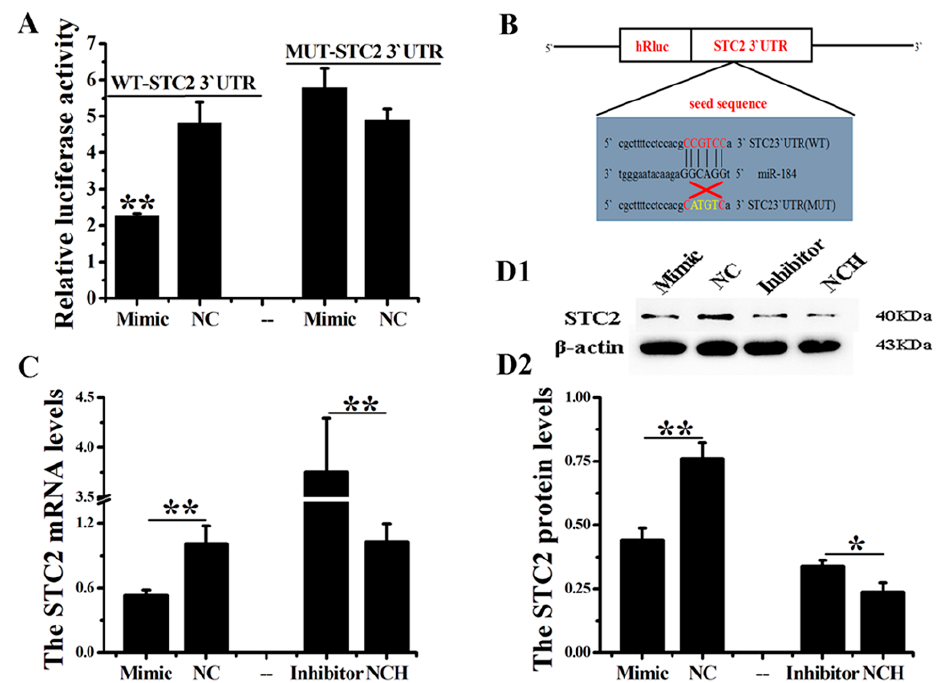
Figure 2. STC2 is the target of miR-184. ( A ) Schematic diagram of dual-luciferase reporter design for the wild-type (WT-STC2) or mutant (MUT-STC2). The red sequence represents the “seed sequence” of miR-184, and the yellow sequence represents the mutant sequence. ( B ) Double luciferase activity was detected after 293T cells were cotransfected with WT-STC2 or MUT-STC2 and miR-184 or NC (negative control). miR-184 upregulates the expression of STC2 at mRNA ( C ) and protein ( D1 , D2 ) levels. STC2 expression was detected using RT-qPCR and normalized to β -actin. WB analysis was used to measure expression at the protein level. The optical density method was standardized to the density of β -actin in the same lane. Data is expressed as the “mean ± SEM” of three values, ** p < 0.01; * p < 0.05. WB, western blot; SEM, standard error of the